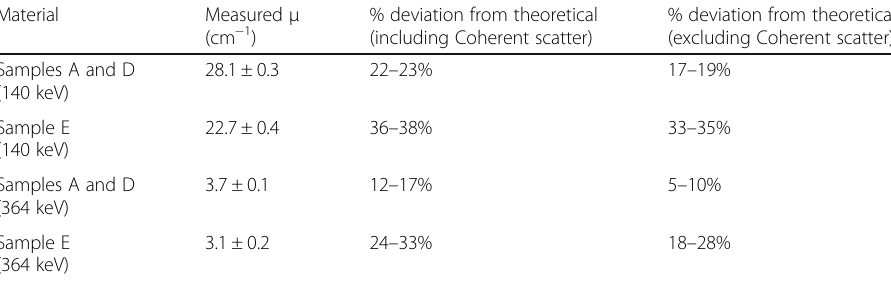
% deviation from theoretical (excluding Coherent scatter)